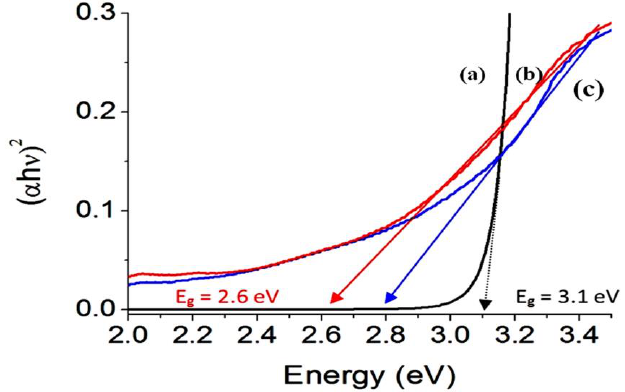
Figure 11. Band gap of ( a ) ZA-500, ( b ) NHZ-1-500, and ( c ) NHZ-2-500.